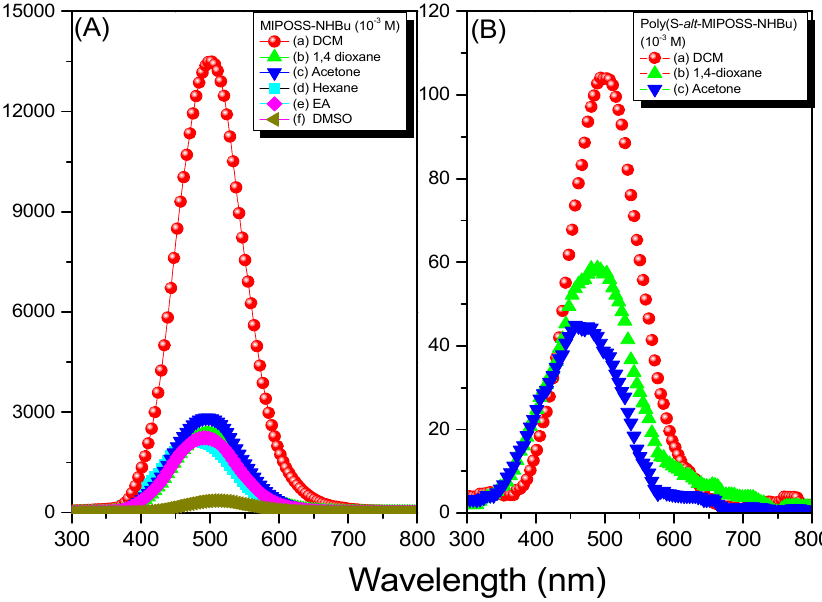
Figure 12. Fluorescence spectra of the: ( A ) monomer MIPOSS-NHBu; and ( B ) copolymer poly(S- alt - MIPOSS-NHBu), in various solvents at a concentration of 10 − 4 M (excitation: 330 nm).